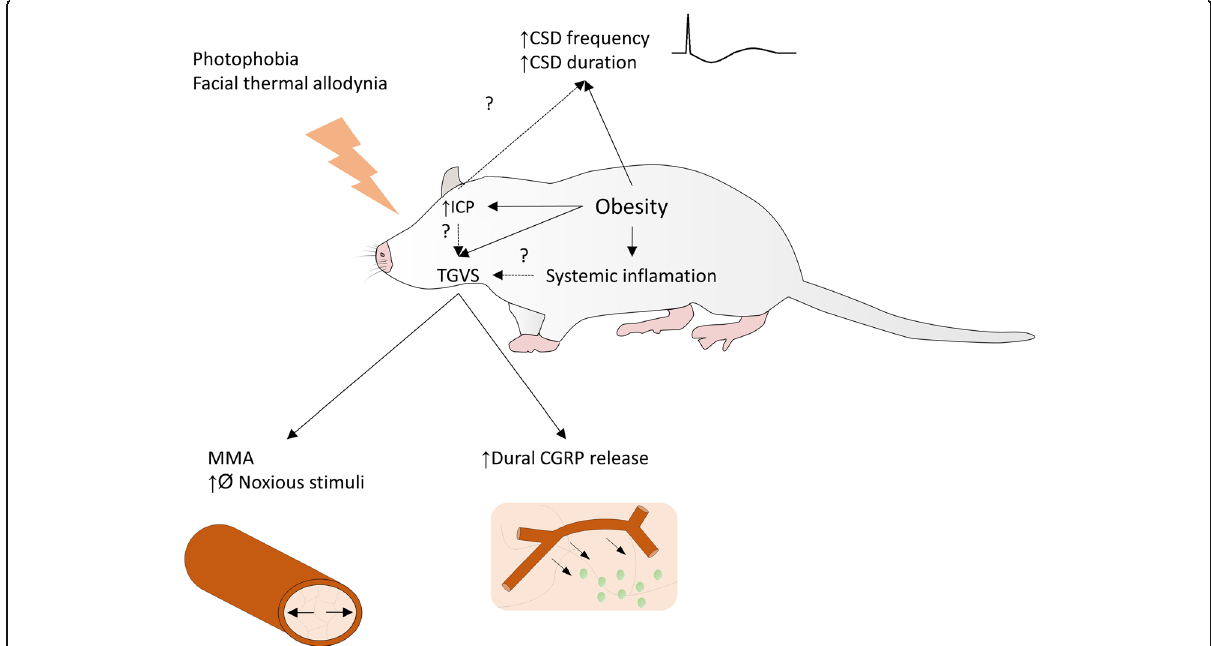
Fig. 1 The effects of obesity on headache and the trigeminovascular system. Obesity has been demonstrated to affect several aspects associated with headache. Obesity alters headache-like behavior including increasing photophobia and thermal allodynia. This is associated with a series of physiological differences including increased cortical spreading depression (CSD) frequency. The trigemino-vascular system (TGVS) also is altered with obesity where the release of calcitonin gene related peptide (CGRP) from dura middle meningeal artery (MMA) calibre (Ø) display a greater response to noxious stimuli. The molecular underpinnings of these are unknown and it is unknown how obesity related systemic inflammation and intracranial pressure (ICP) alter the TGVS or headache in